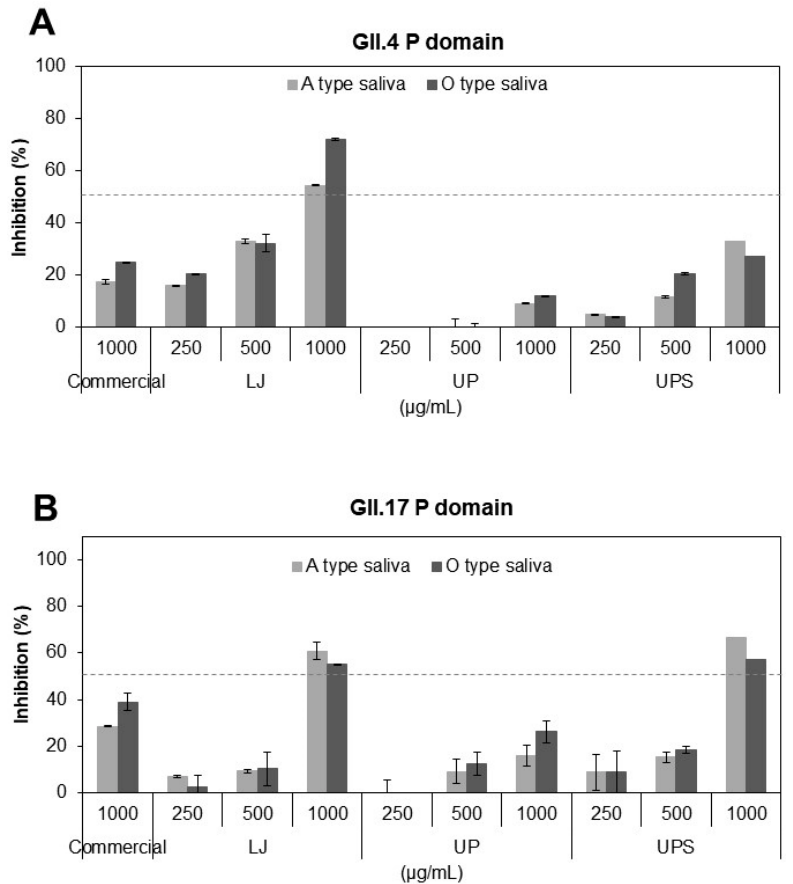
Figure 1. Inhibition of binding of the P domains of human norovirus (HuNoV) GII.4 ( A ) or GII.17 ( B ) to A- or O-type saliva by the fucoidans of Laminaria japonica (LJ), Undaria pinnatifida (UP) and Undaria pinnatifida sporophyll (UPS). Inhibition was quantified by ELISA using anti-NoV antibodies against GII.4 and GII.17 P domain. A commercial fucoidan ( ≥ 95% purity) was used as a positive control. The dashed line indicates 50% inhibition.